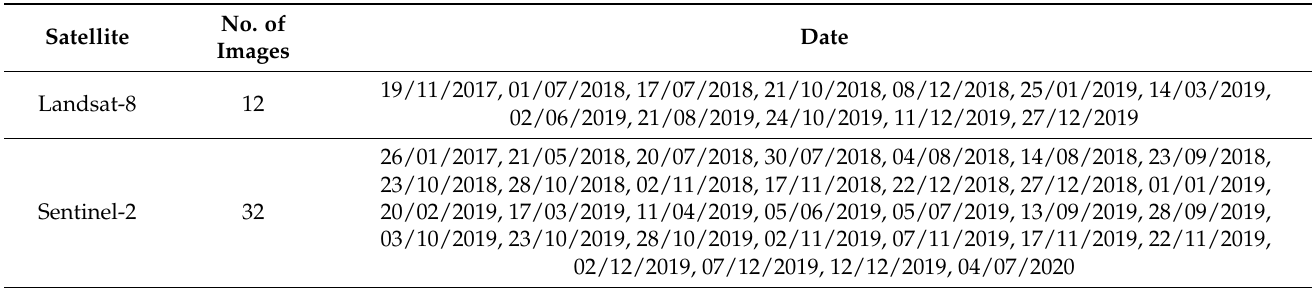
Table 4. Landsat-8 and Sentinel-2 imagery datasets used to assess